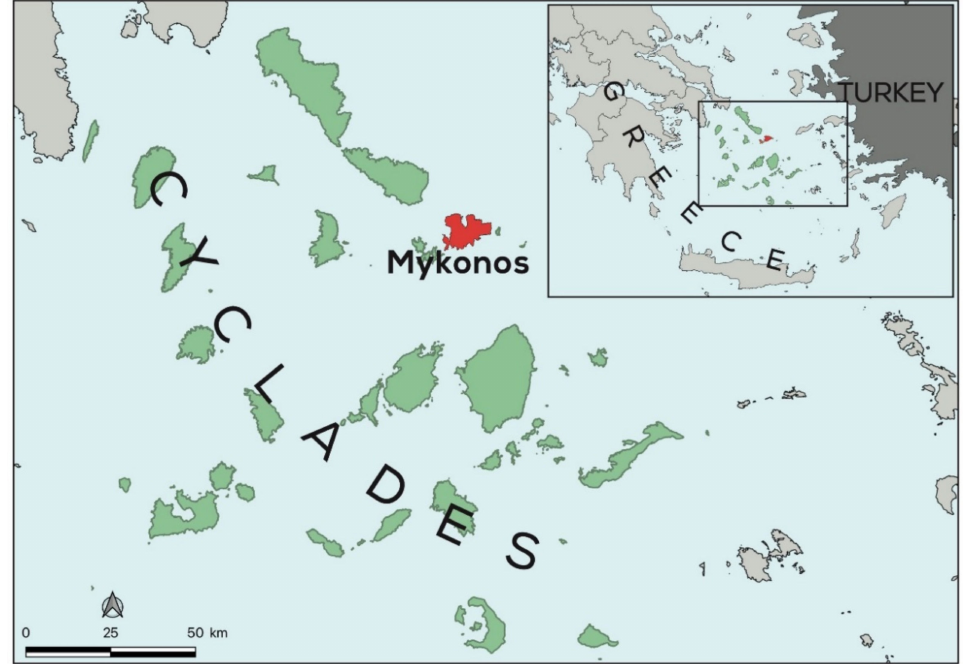
Figure 2. Mykonos and the Cyclades